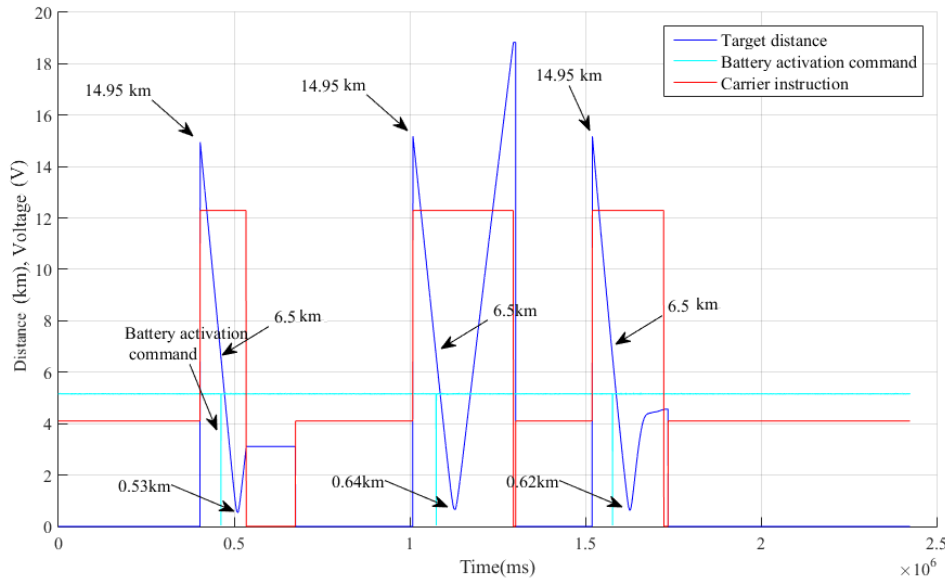
Figure 14. Time sequence of the pod’s power supply.